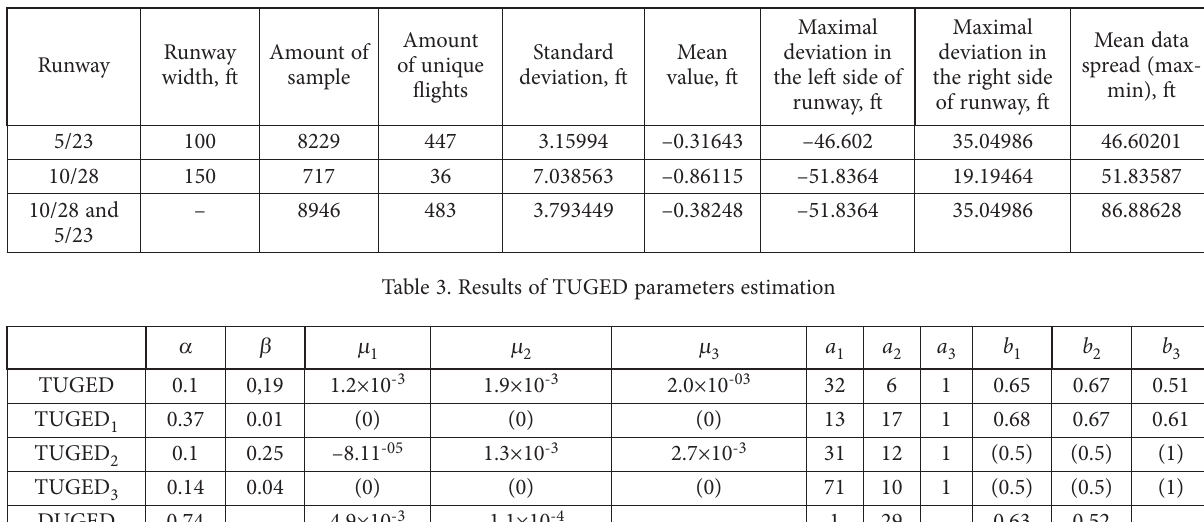
Table 2. Basic parameters of training sample